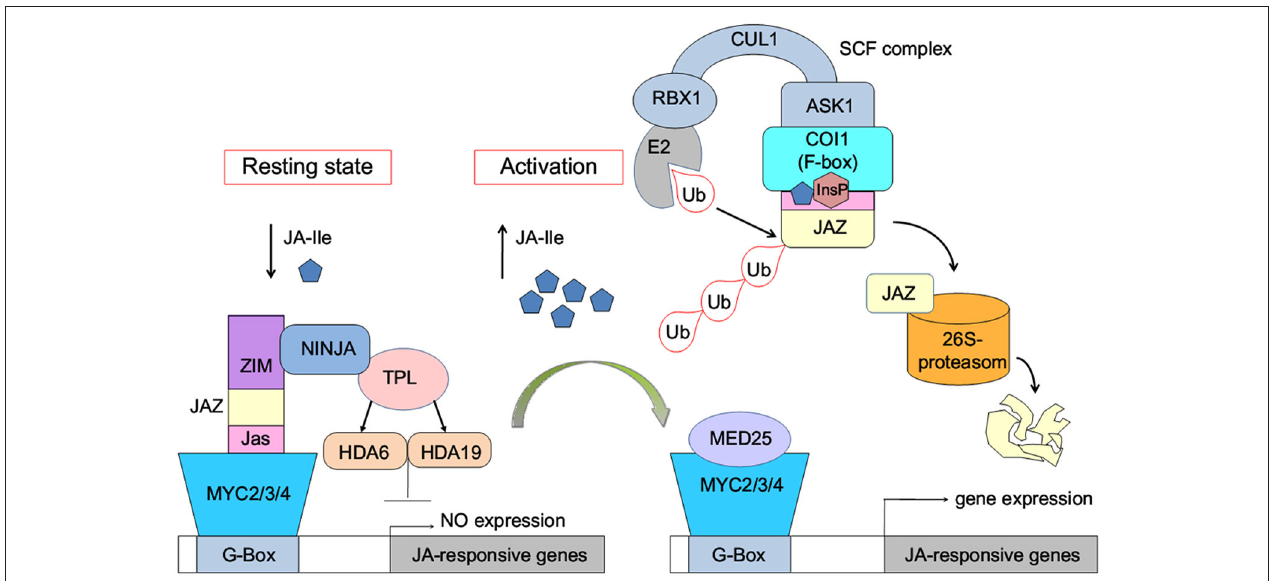
FIGURE 1 | Model of JA-Ile perception via the SCF COI1 -JAZ receptor complex (Wasternack and Hause, 2013; Wasternack and Strnad, 2015; Wasternack and Song, 2016 ). MYC2/3/4, binding to the G-box of a JA-Ile-responsive gene, is repressed by negative regulators such as jasmonate ZIM-domain proteins (JAZs). Novel Interactor of JAZ1 (NINJA) and TOPLESS (TPL), which act via HISTONE DEACETYLASE6 (HDA6) and HDA19, act as co-repressors. Ub, ubiquitin. InsP, inositol phosphate. E2, RBX1, CULLIN1 (CUL1), ASK1, and the F-box protein COI1 are components of the SCF-complex. MED25, subunit 25 of the Mediator complex.